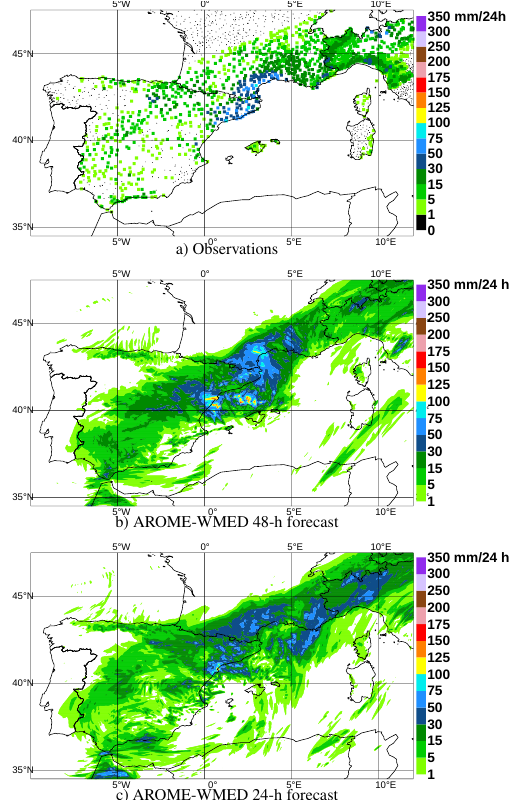
Figure 25. Brightness temperatures ( ◦ C) observed with SEVIRI on 29 September 2012 at 06:00UTC (a) and simulated with AROME- WMED 6h forecast from 29 September 2012, 00:00UTC (b) and with 30h forecast from 28 September 2012, 00:00UTC (c)